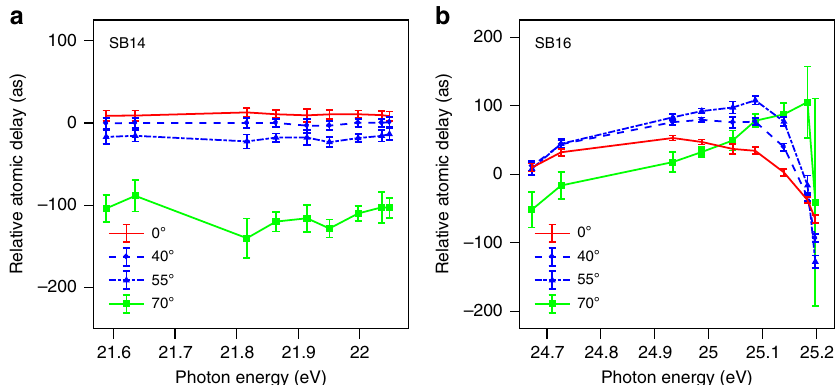
Fig. 6 Energy and angle-resolved time delays measured in the Lund experiment. Relative atomic delay as a function of sideband photon energy (for two- photon transitions) for different emission angles for SB14 ( a ) and SB16 ( b ). The error bars represent the standard deviation as extracted by a series of independent